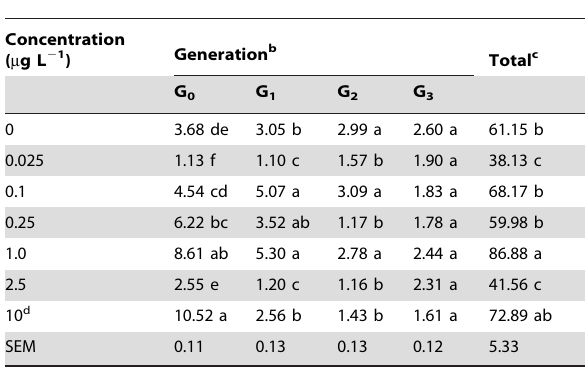
Table 4. Least-squares means of two-generational fecundity a following topical exposure of M. persicae to sublethal concentrations of imidacloprid.